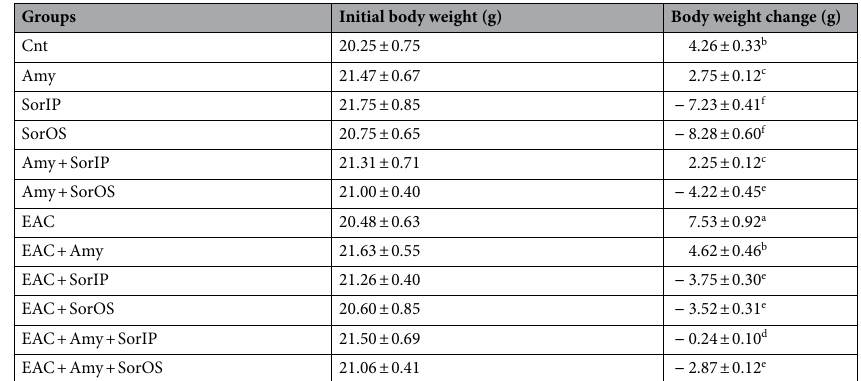
Table 1. Mice initial body weights and change in body weight in different experimental groups. Data were presented as means ± SEM. Small (a–f) letters showed the marked change at P ≤ 0.05. The significant were expressed by dissimilar letters in the same column. Cnt Control, Amy Amygdalin, Sor Sorafenib, EAC Ehrlich ascetic carcinoma, IP Intraperitoneal, OS Per os